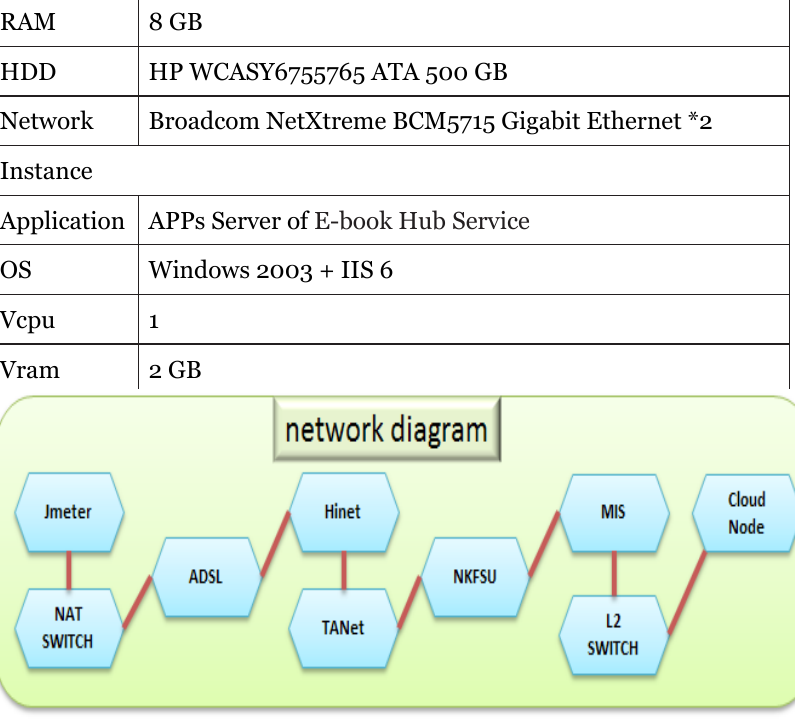
Figure 14. The network path for the